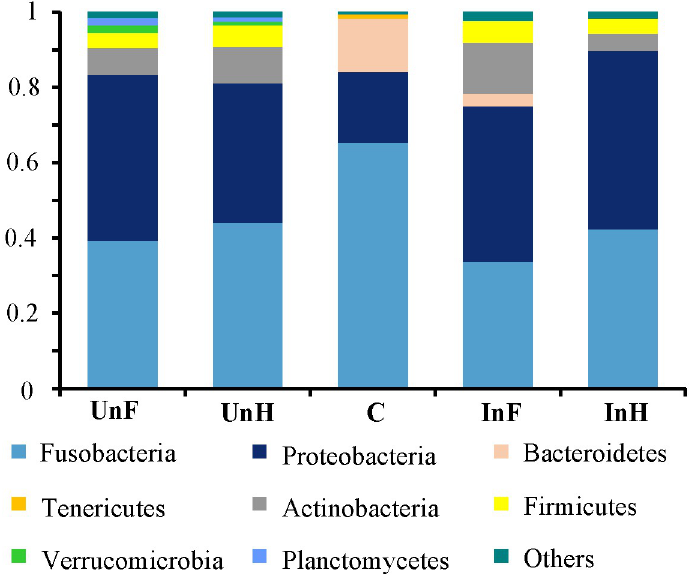
Fig 1. Microbiota composition in foregut and hindgut of grass carp and S . acheilognathi surface at the phylum level. UnF, uninfected with S . acheilognathi in the foregut of grass carp; UnH, uninfected with S . acheilognathi in the hindgut of grass carp; C, the surface of S . acheilognathi ; InF, infected with S . acheilognathi in the foregut of grass carp; InH, infected with S . acheilognathi in the hindgut of grass carp; Others, the sum of different taxa with an abundance less than 1% in the samples.